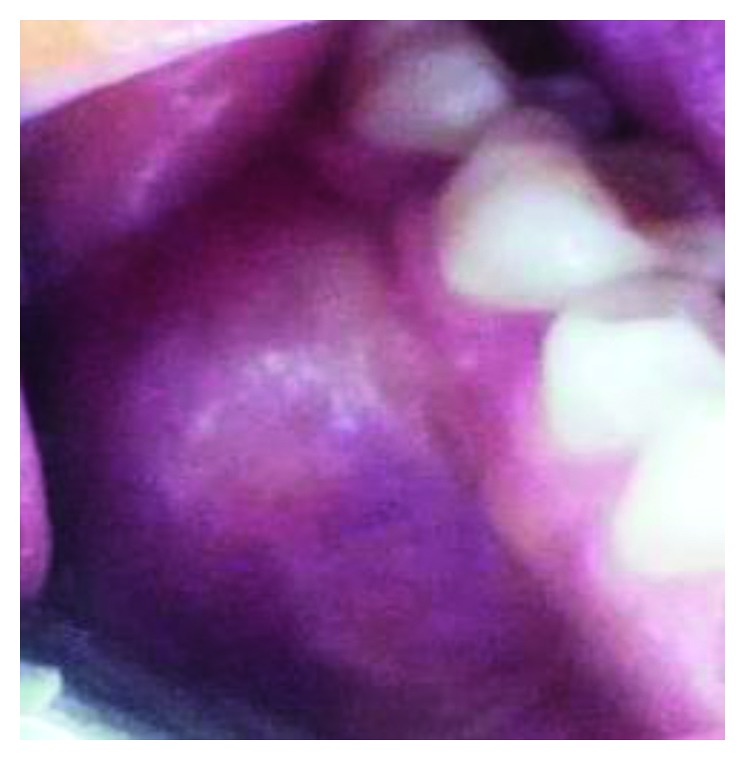
Clinical picture: a bulbous mass of 4 × 4 cm in the vestibule on the right side, extending from the distal aspect of 44 to the 47.